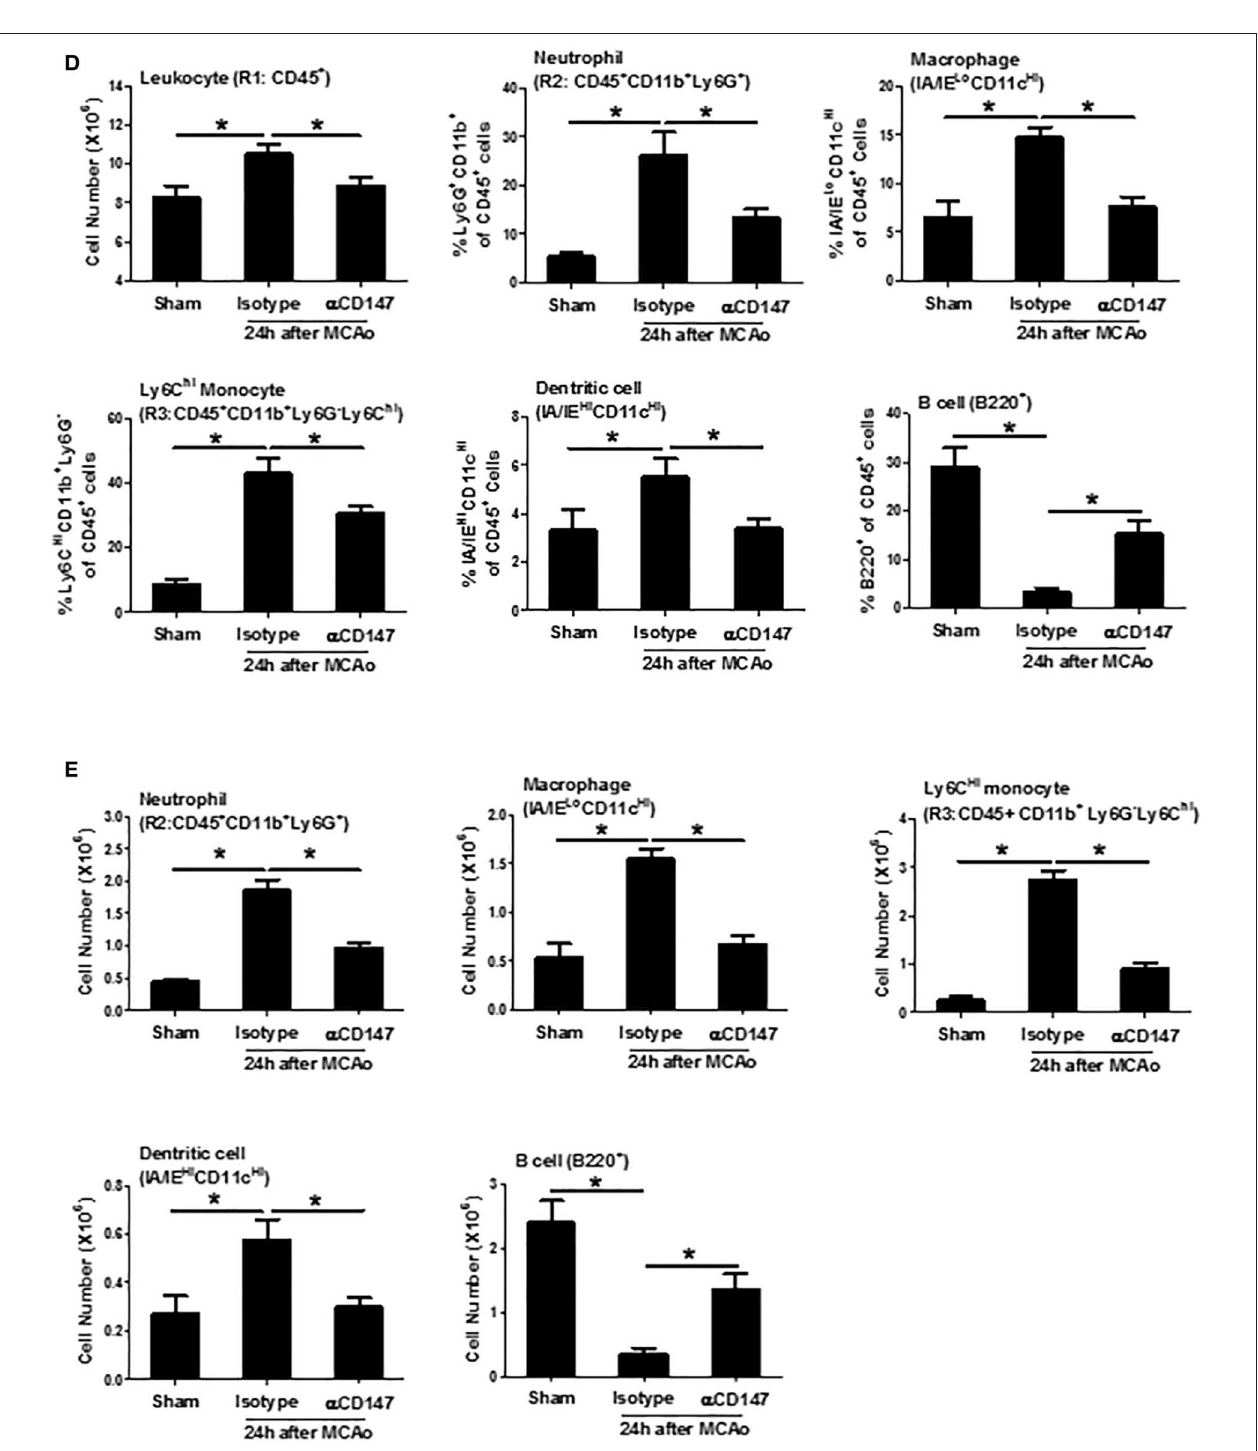
FIGURE 3 | Inhibition of CD147 modulates the changes of leukocyte subpopulations in the lung after stroke. (A) Representative flow cytometric dot plots of R1: total leukocytes (CD45 + ), R2: neutrophils (CD45 + CD11b + Ly6G + ), and R3: ly6C Hi monocytes (CD45 + CD11b + Ly6G − Ly6C Hi ) in the isolated lung cells from indicated groups. Lung infiltrating cell was isolated using enzyme digestion method at 24h after stroke. (B) Representative flow cytometric dot plots of lung conventional dendritic cell (cDC, identified as CD11c Hi /IA/IE Hi ) and macrophage (M Φ , CD11c Hi /IA/IE Lo ) populations. (C) Representative flow cytometric dot plots of B cell population (B220 + ). (D,E) The number and frequency of cell subpopulations in the indicated groups. n = 6 per group. * P < 0.05.